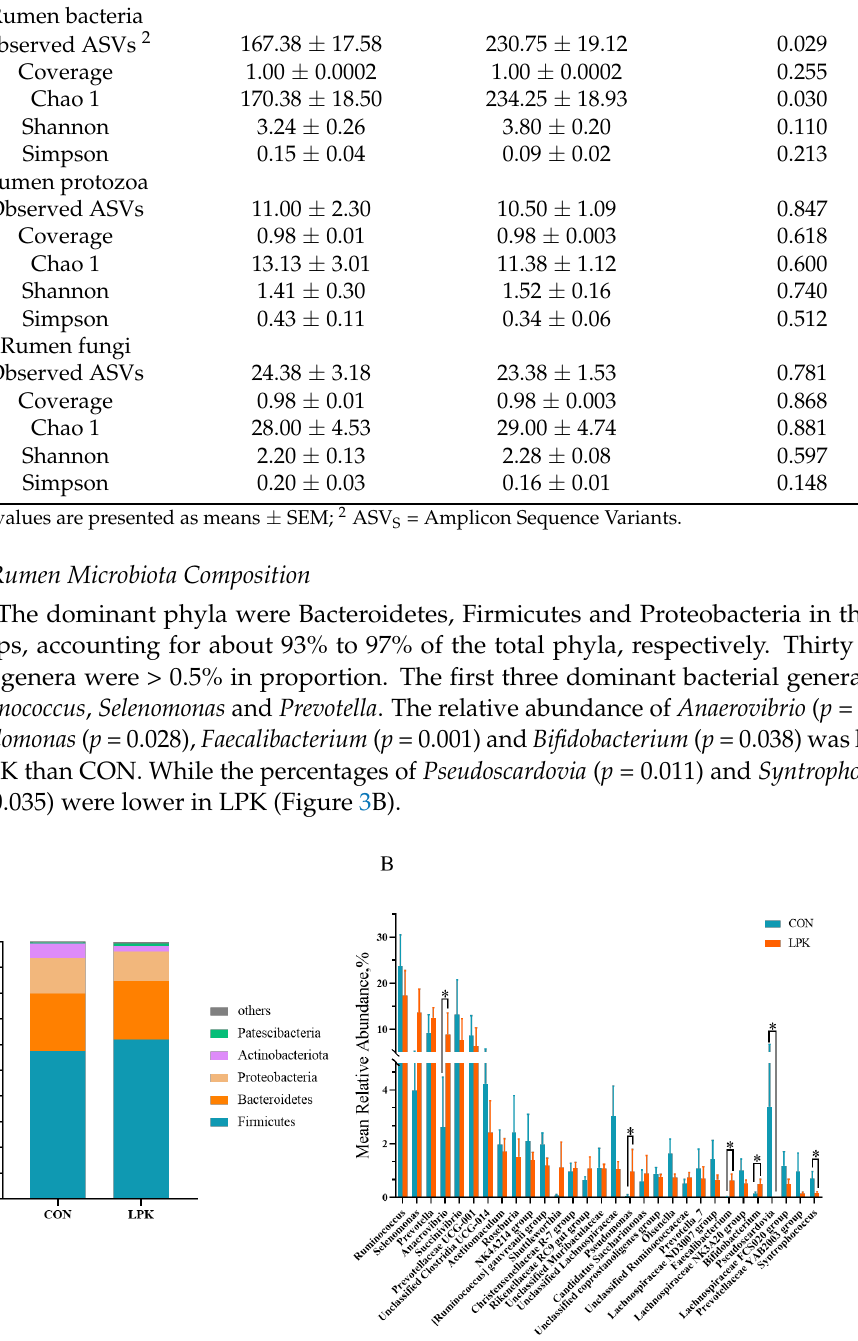
Figure 3. The bacterial community in the rumen of Hu sheep: ( A ) The mean relative abundance of phylum ≥ 0.5% in at least one group is present. ( B ) The mean relative abundance of genus ≥ 0.5% in at least one group is present. Error bars, SEM. *, p < 0.05. CON = control group; LPK = live Pichia kudriavzevii group. All protozoa identified belonged to the phylum Ciliophora. At the genus level, En- todinium was the most abundant genus, accounting for 60.25% and 77.14% in LPK and CON, respectively. The relative abundances of Polyplastron ( p = 0.002) and unclassified Trichostomatia ( p = 0.004) were higher in LPK than CON, while the percentage of unclas- sified Hypotrichia was lower in LPK ( p = 0.032, Figure 4B).